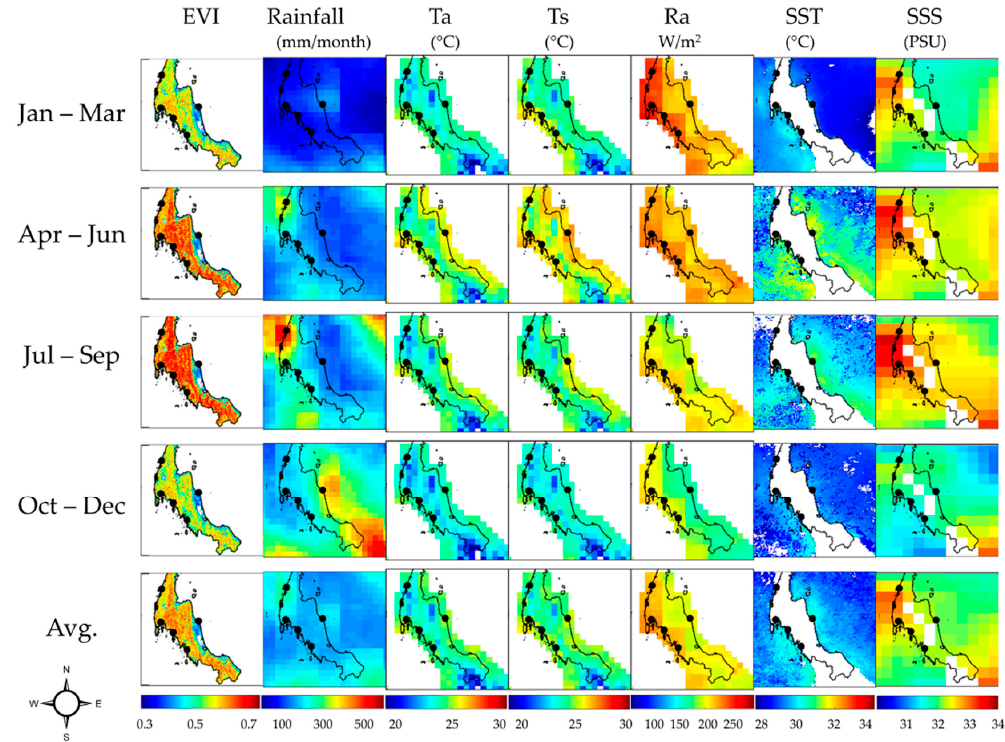
Figure 9. Color-coded spatial variability of seasonal EVI and seasonal environmental / climate driver Figure 9. Color ‐ coded spatial variability of seasonal EVI and seasonal environmental/climate driver values at quarterly intervals. The points are the location of the study values at quarterly intervals. The points are the location of the study sites.